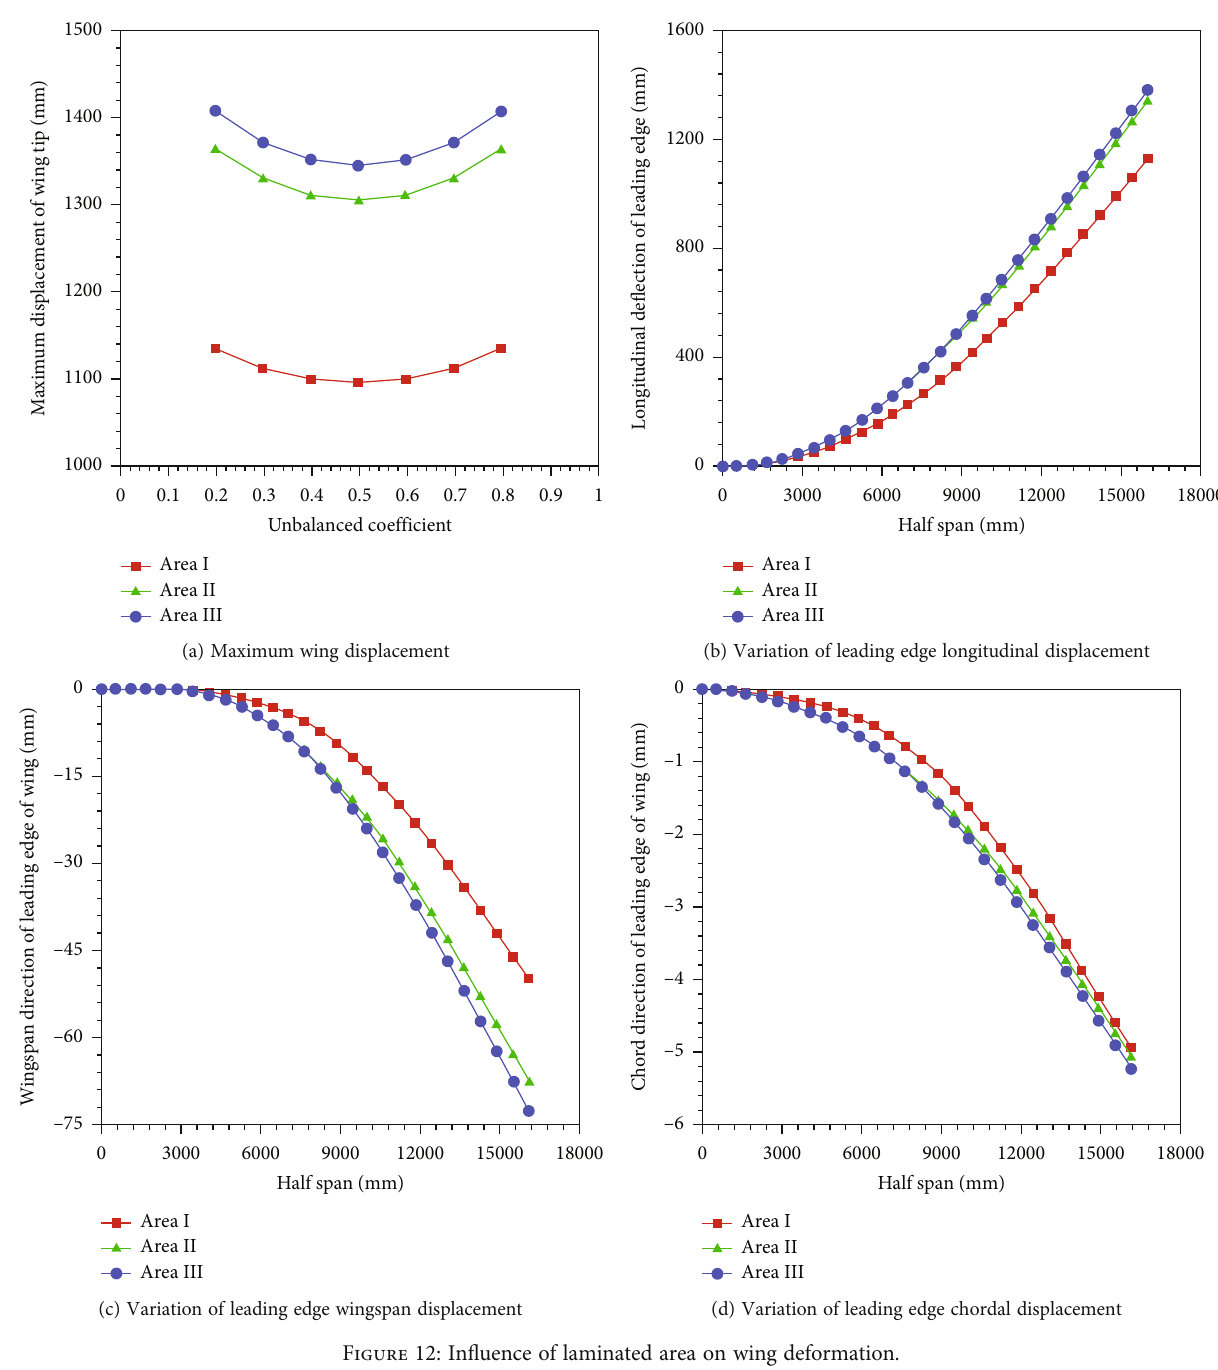
Figure 12: In fl uence of laminated area on wing